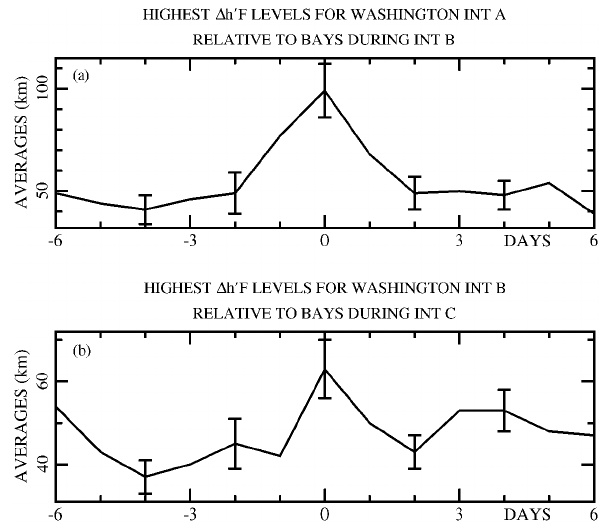
Fig. 8. High Wa 1h 0 F values relative to (a) 17 INTB bays and (b) 23 INTC